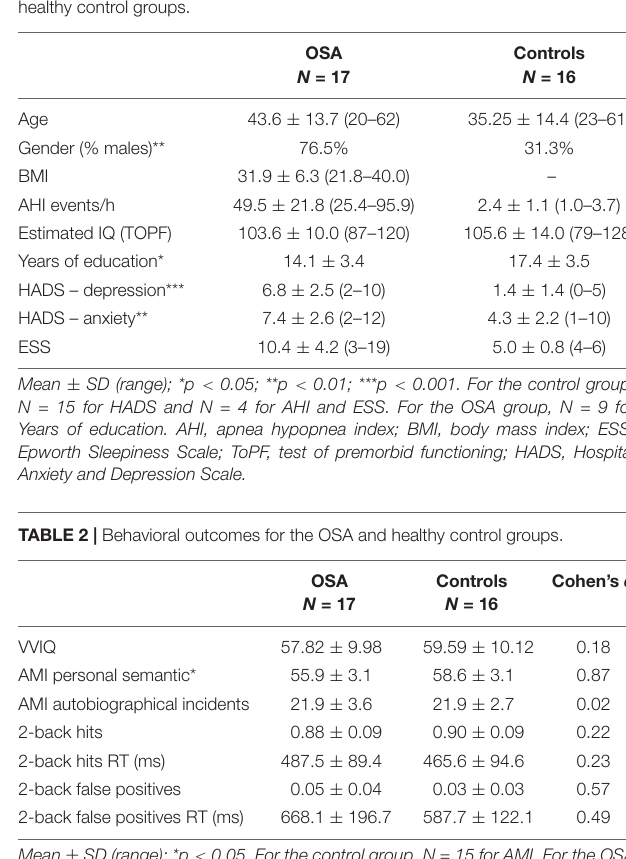
TABLE 1 | Demographics, mood, and sleep variables for the OSA and healthy control groups.